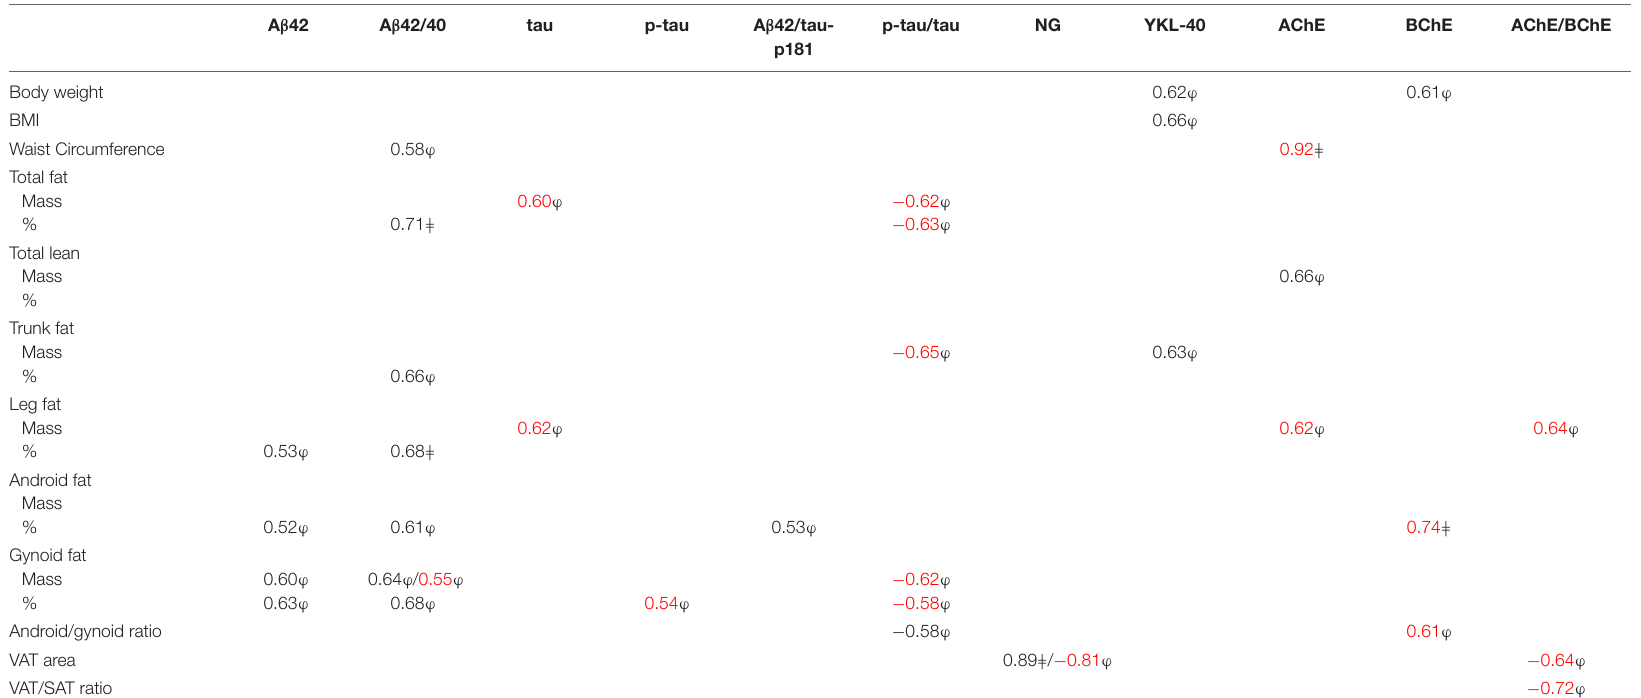
TABLE 3 | Correlations between changes in adiposity and CSF biomarkers on the MMK and AHA diets.